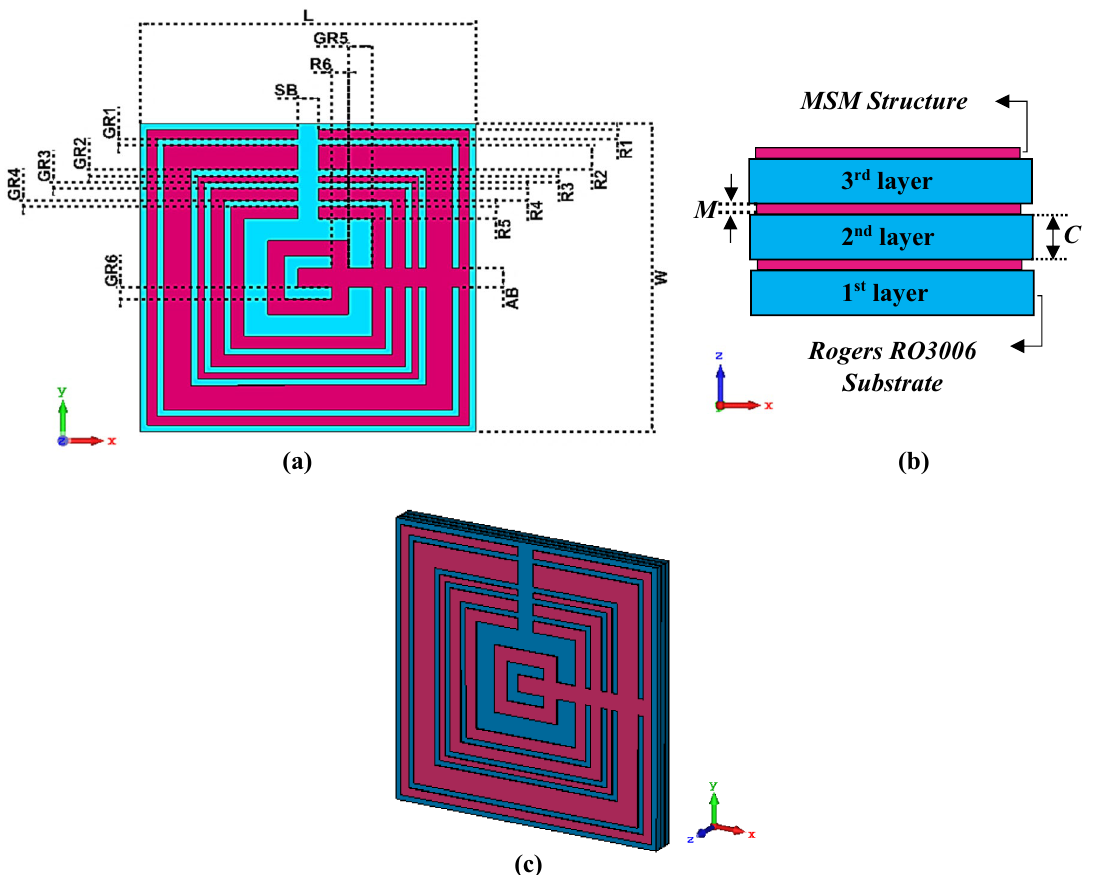
Figure 1. The MSM structure: (a) top view, (b) front view, (c) isometric projection